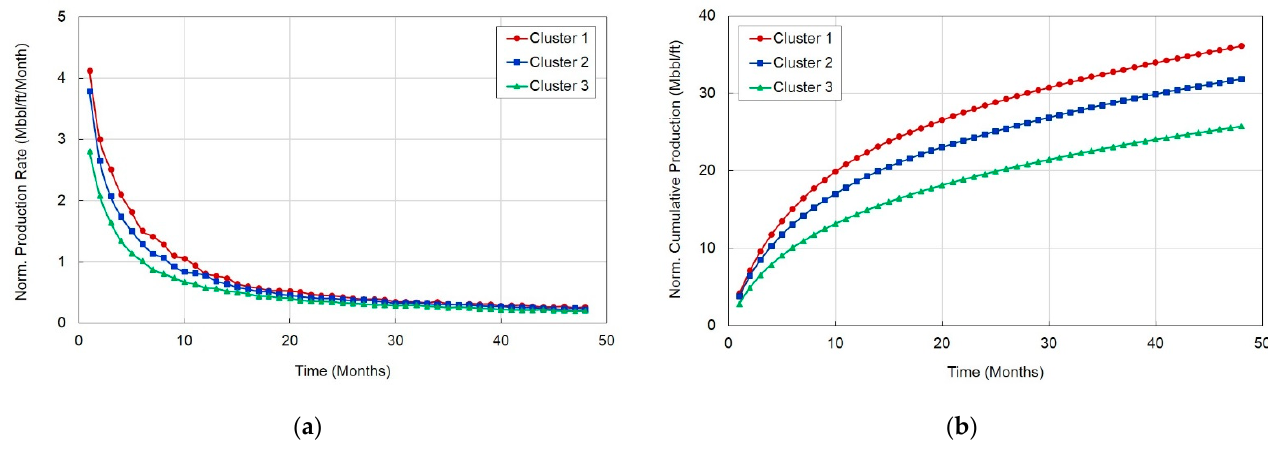
Figure 12. Normalized production of each group: ( a ) the average production rate; ( b ) the average cumulative production.